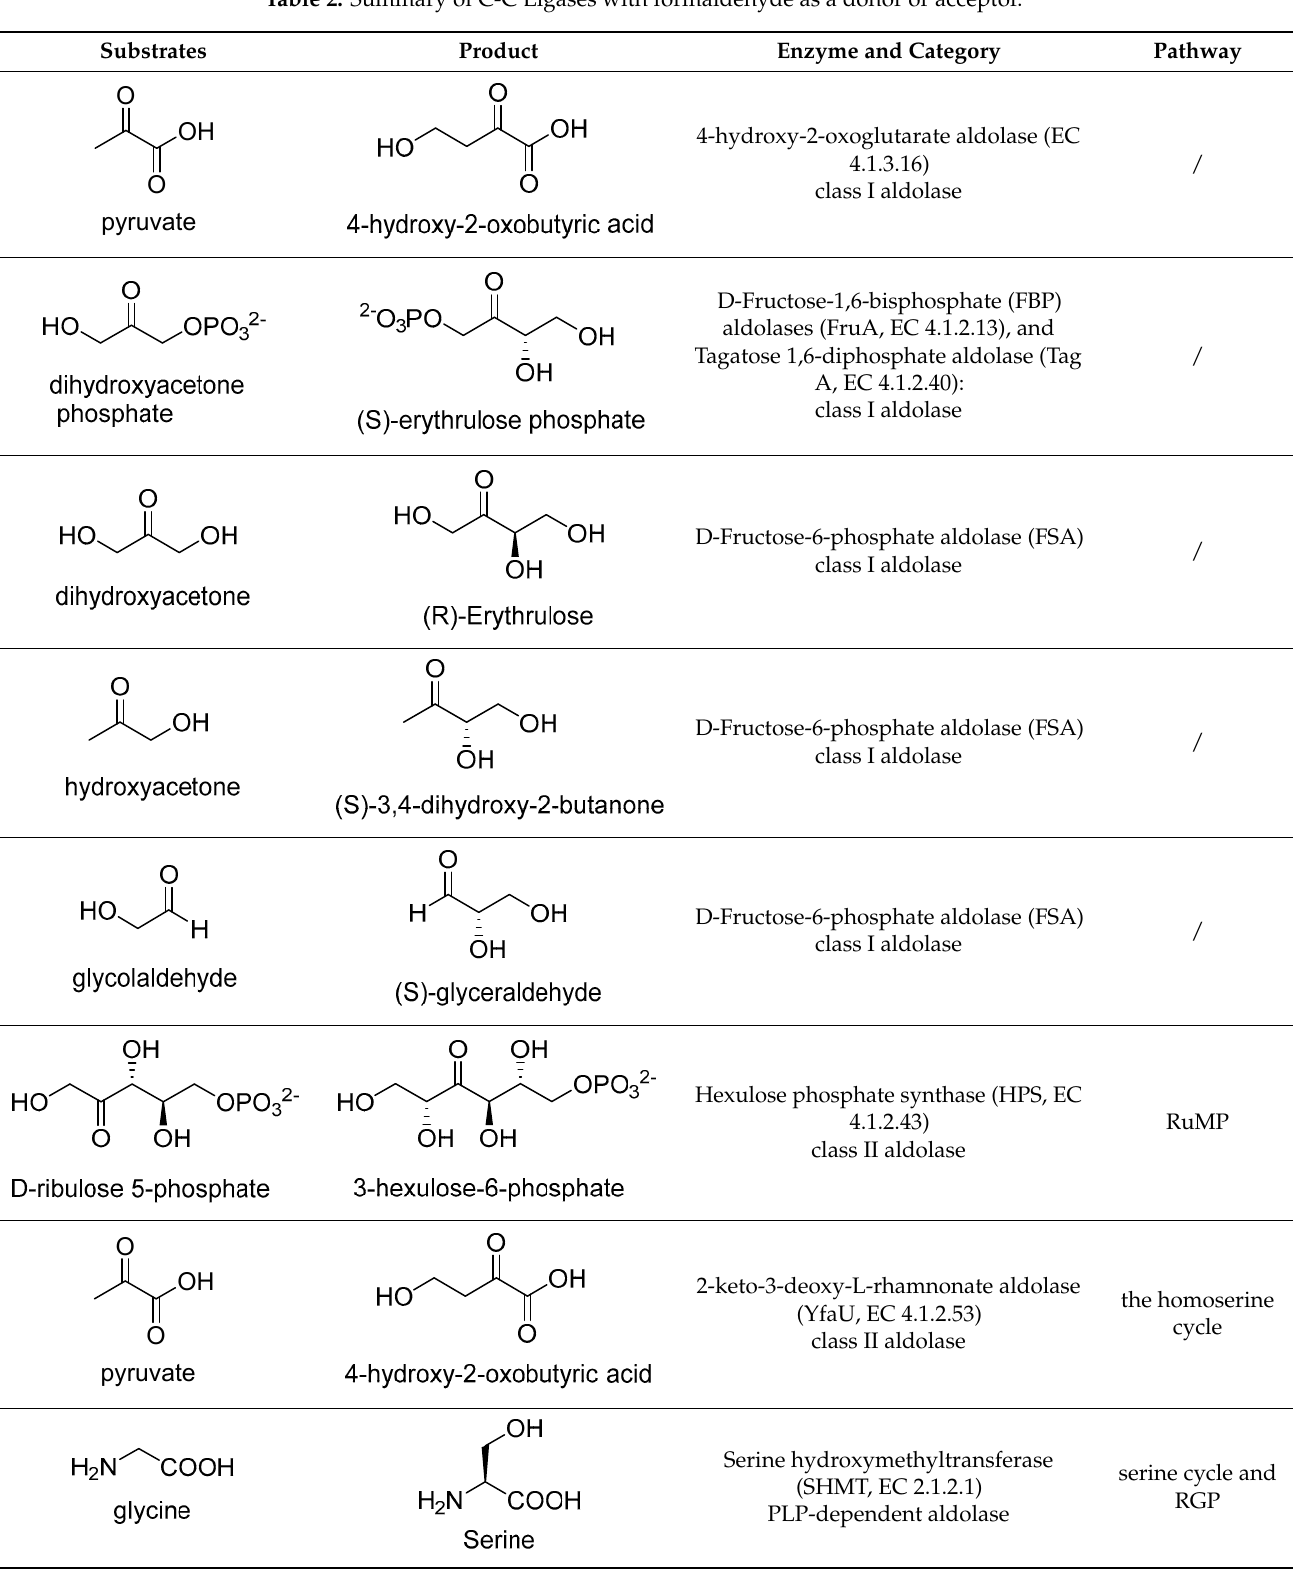
Table 2. Summary of C-C Ligases with formaldehyde as a donor or acceptor.